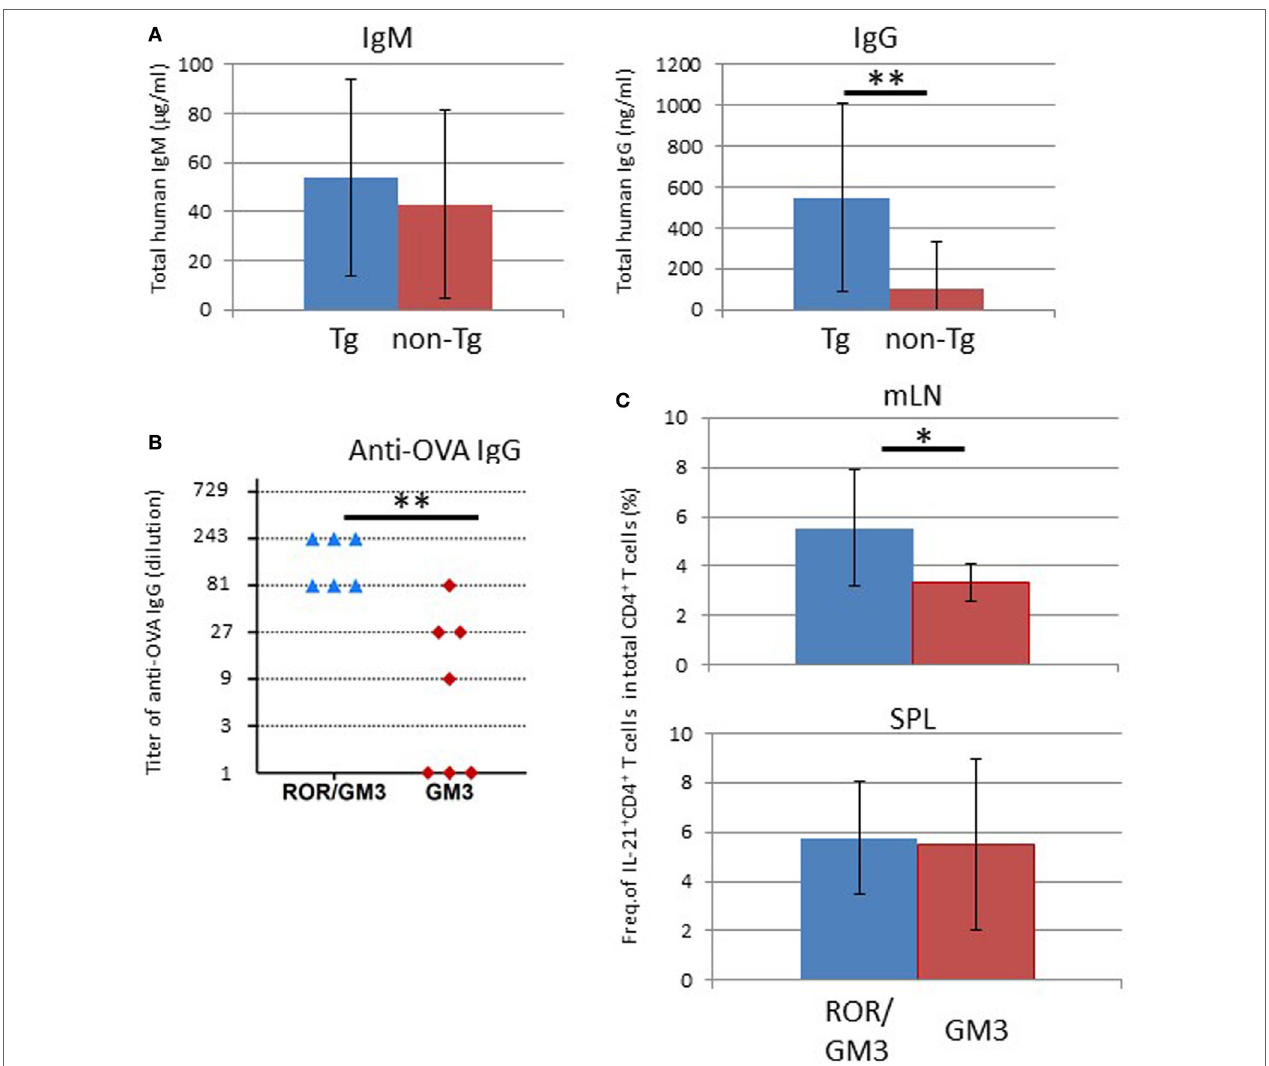
FigUre 9 | Enhanced humoral responses in NOG-pROR γ t- γ c Tg mice. (a) Total IgM and IgG levels in plasma. Plasma was prepared 24 weeks after hematopoietic stem cell (HSC) transplantation and total IgM and IgG levels were quantified by enzyme-linked immunosorbent assay (ELISA). Mean ± SD from NOG-pROR γ t- γ c Tg ( n = 12) and NOG non-Tg mice ( n = 11). Statistical significance was evaluated by Student’s t -test (** p < 0.01). (B) ELISA results for ovalbumin (OVA)-specific human IgG. NOG-pROR γ t- γ c/GM-CSF/IL-3 Tg (ROR/GM3) ( n = 6) or NOG-GM-CSF/IL-3 Tg (GM3) ( n = 7) mice were transplanted with HSCs. After confirming T-cell differentiation in the peripheral blood at 12 weeks post-HSC engraftment, mice were immunized three times with OVA/Alum. Plasma was collected 4 days after the final boost. Titers of individual mice are shown. Statistical significance was evaluated by Student’s t -test (** p < 0.01). (c) Increase in the number of IL-21-producing CD4 + T cells in lymph nodes (LNs). Spleen and mesenteric LNs from OVA-immunized NOG-ROR/GM3 or NOG-GM3 mice were stimulated with phorbol myristate acetate/ionomycin for 4 h in the presence of Brefeldin A. Cytokines were stained after fixation and permeabilization. Mean ± SD frequencies of IL-21 + CD4 + T cells among total CD4 + T cells. Statistical significance was evaluated by Student’s t -test (* p <